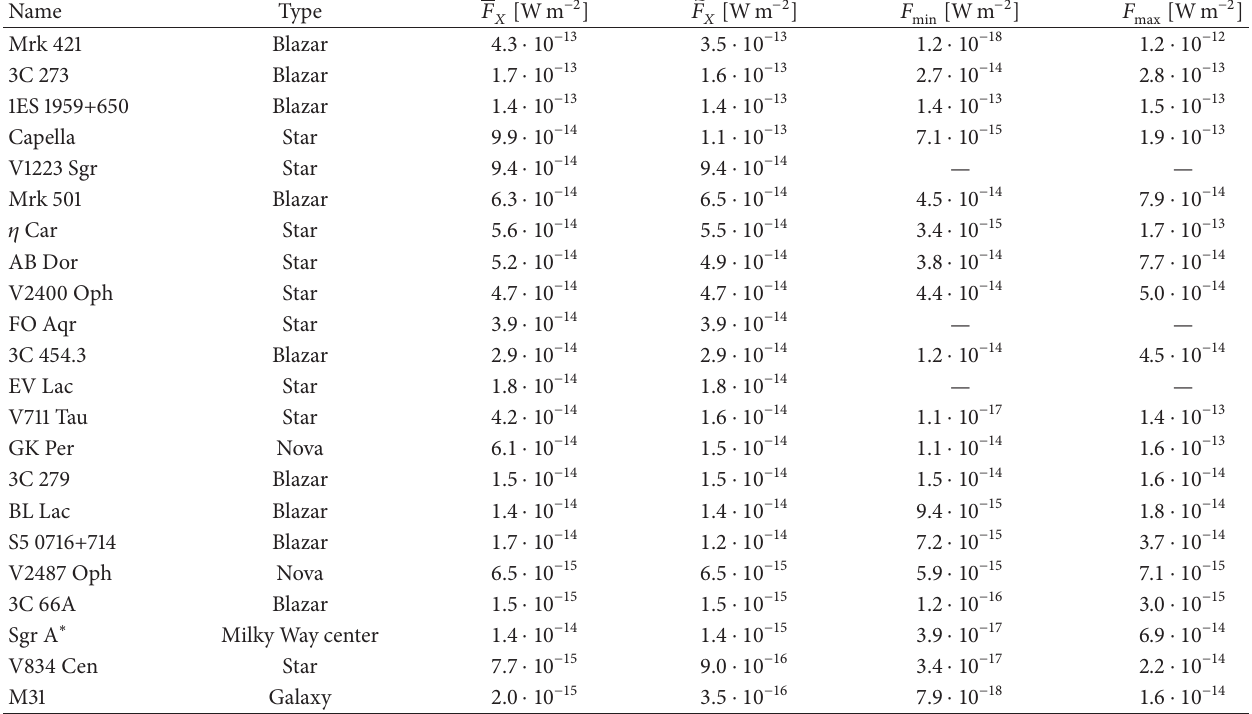
Table 1: List of potential astronomical X-ray sources to be used as observational candidates for tests of X-ray optics. Data are computed from the minimal 𝐹 min , and the maximal value 𝐹 max .